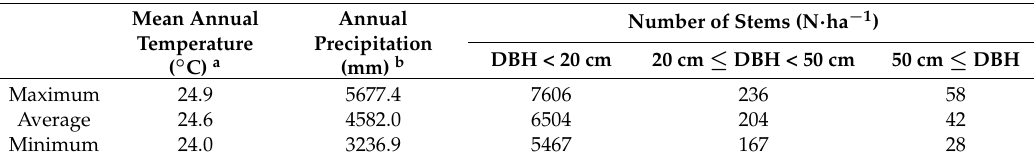
Table 1. Stand condition of the study